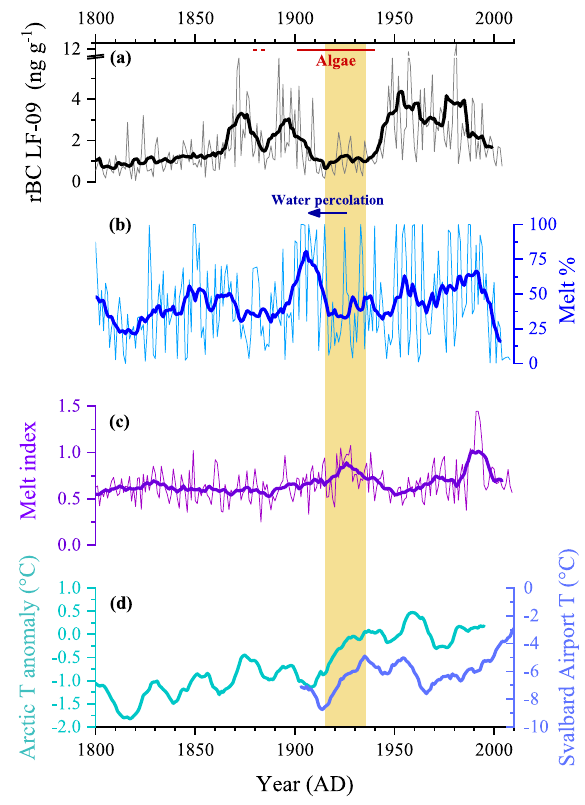
Figure 6. Influence of melting on the LF-09 rBC record since 1800. Comparison of (a) LF-09 rBC concentrations with (b) LF-09 melt percent (Wendl et al., 2015), (c) LF-09 melt index calculated as log ( [ Na + ] / [ Mg 2 + ] ) , (d) temperature anomalies from the whole Arctic (McKay et al., 2014), and the temperature record from Sval- bard Airport, Longyearbyen (Nordli et al., 2014). Thin lines are annual averages and bold lines 11-year moving averages. The yel- low bar represents the time period of the early 20th century Arctic warming responsible for enhanced melting in the LF-09 ice core. Time periods with algae, either in the LF-97 (Hicks and Isaksson, 2006) or LF-09 records, are represented by a red